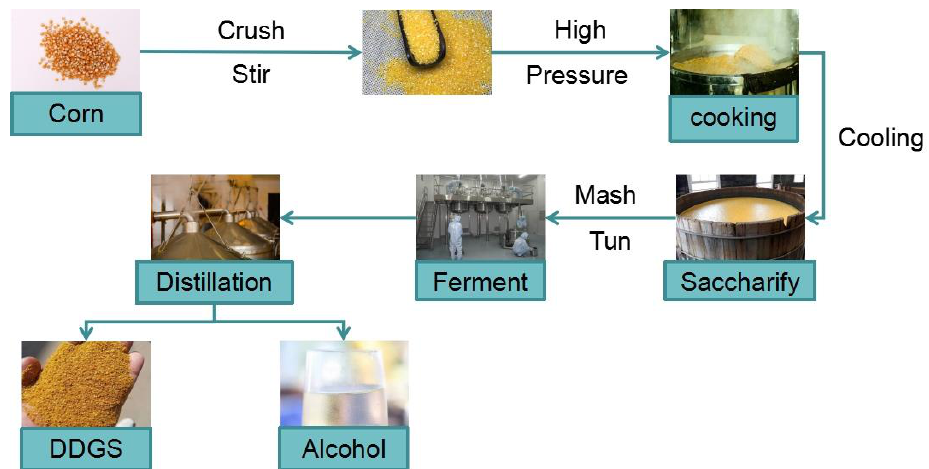
Figure 2. Process flow diagram of ethanol and DDGS production.